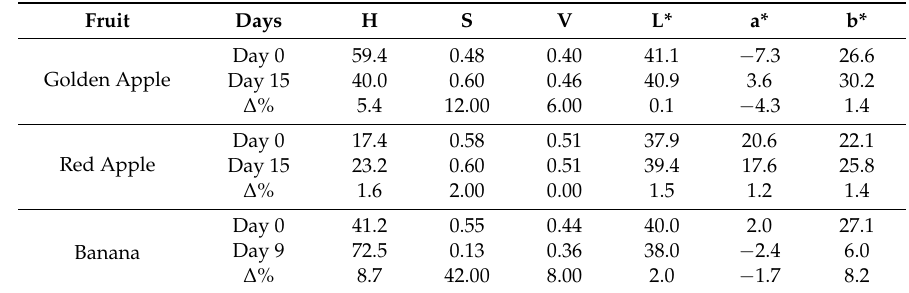
Table 3. Average readings of HSV and L*a*b of 100 samples. Comparative change of each parameter over